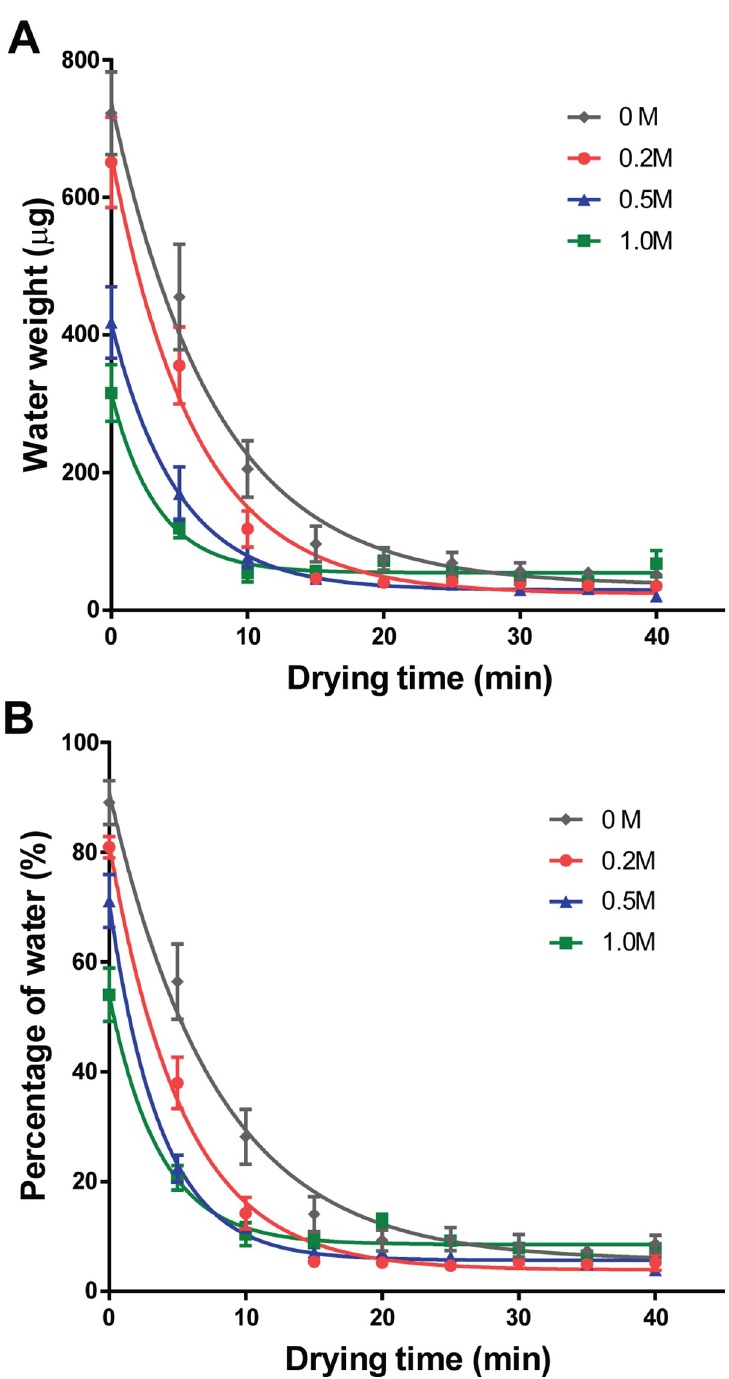
Fig 2. Kinetics of water content in tissues during microwave drying. Ovarian tissues were exposed to 0 M, 0.2 M, 0.5 M, or 1.0 M trehalose before microwaving for 0 to 40 min. Water contents were expressed as (A) water weight ( μ g) and (B) percentage of water weight over total tissue weight. Values are mean ± SEM. Drying curves were fitted to a logarithmic model Eq.(1).